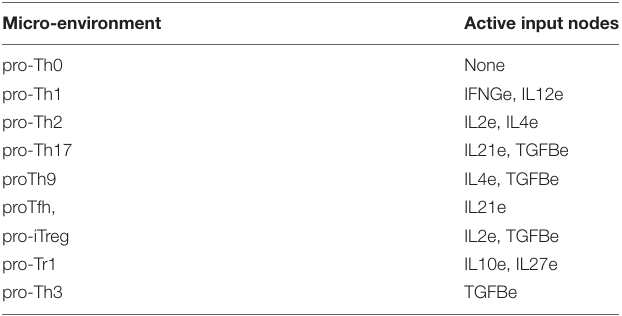
TABLE 2 | Exogenous cytokines in different environments included in the CD4 + T cell regulatory network.